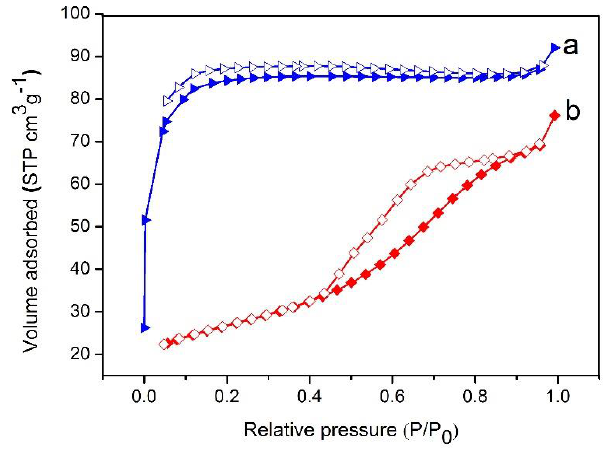
Figure 7. N 2 adsorption–desorption isotherms of the Fe 3 O 4 @MIL-100(Fe) support ( a ) and the immobilized lipase ( b ).